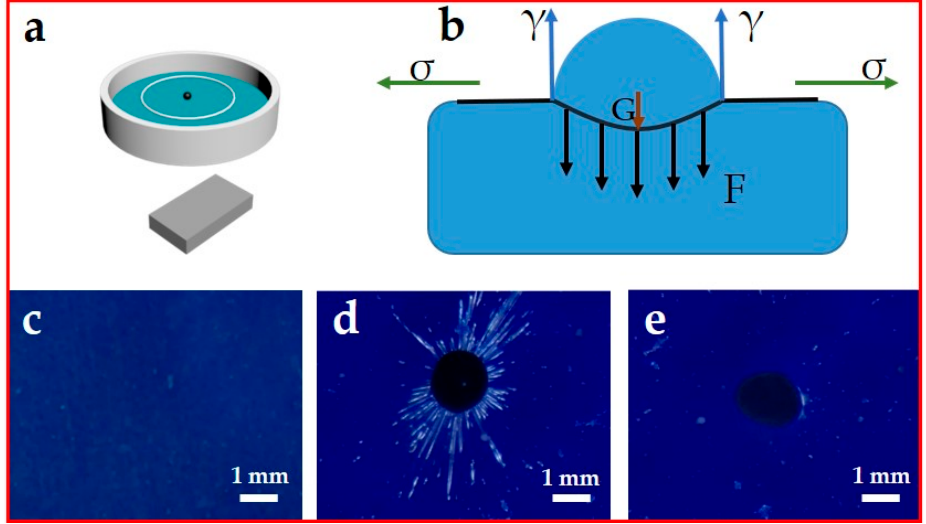
Figure 1. ( a ) Schematic diagram of the magnetically induced wrinkling of a floating PS film. ( b ) Forces that the floating PS film are subjected to when a magnetic droplet is dipped on the floating PS film: σ is the surface tension of water, γ is the capillary force exerted by the magnetic droplet, G is the gravity of the magnetic droplet and F is magnetic force. ( c ) The floating PS film with nothing on it. ( d ) The floating PS film with a 4 μ L magnetic droplet on it. ( e ) The floating PS film with a 4 μ L magnetic droplet wrapped with PTFE powders on it. The thickness of PS film is 100 nm in ( c – e ).